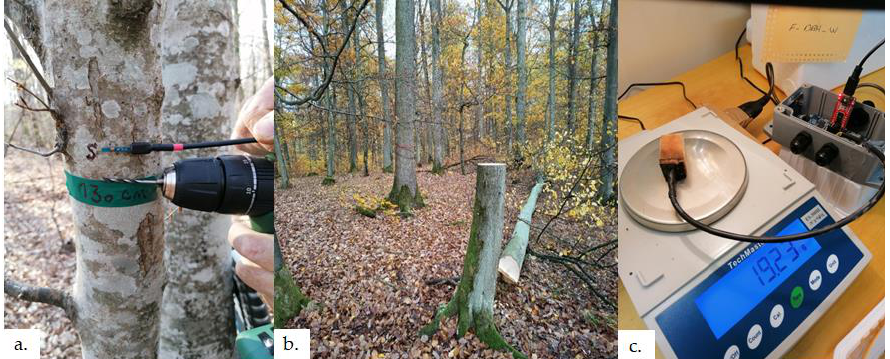
Figure 5. ( a ) Installation of Ref probe at DBH, 10 days before harvesting wood samples, ( b ) harvesting beech and oak trees to collect fresh-cut wood samples including Ref probes, and ( c ) using harvested samples to conduct the species-specific calibration for Ref probe TT+.